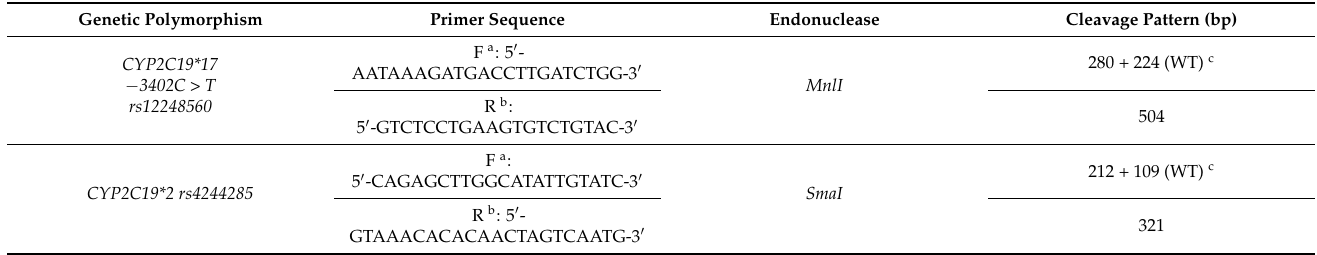
Table 1. Primer sequences and enzymes were used to determine cytochrome P450 2C19 (CYP2C19) polymorphisms and restriction fragments in the PCR-RFLP